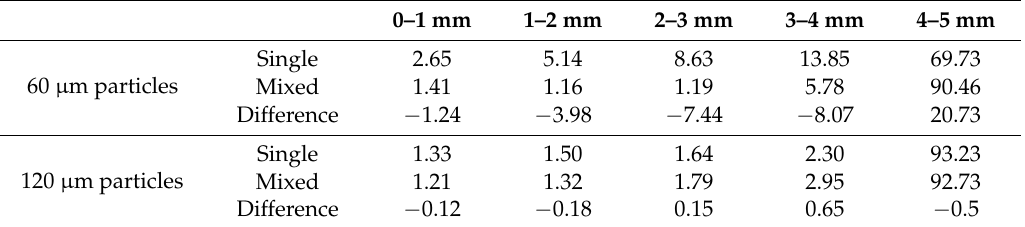
Table 8. Concentration distribution of 60 and 120 µ m particles in the cylinder section.